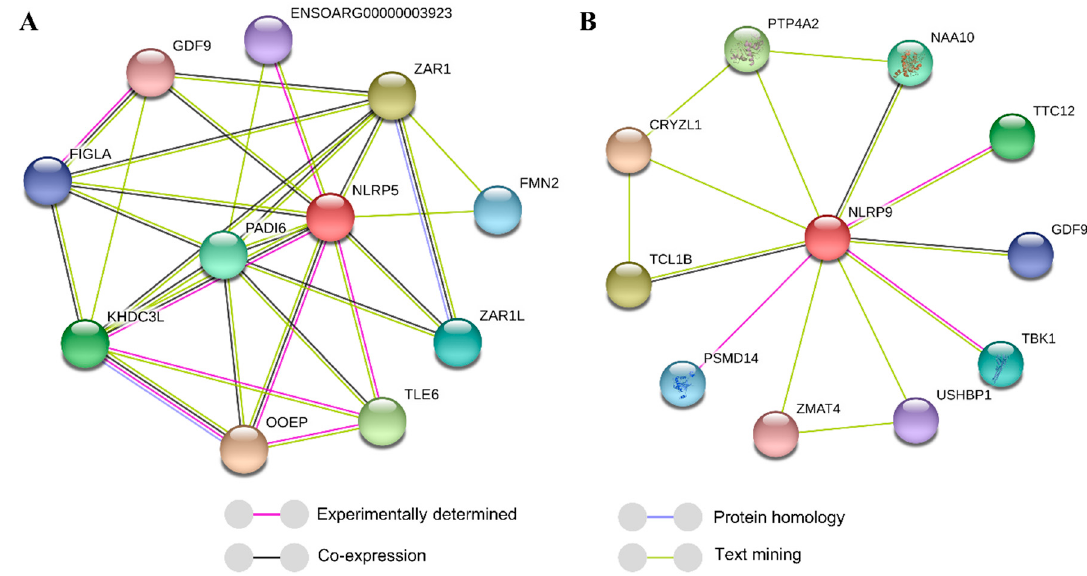
Figure 1. Interactions between proteins including NLRP5 ( A ) and NLRP9 ( B ), as predicted by the STRING database.